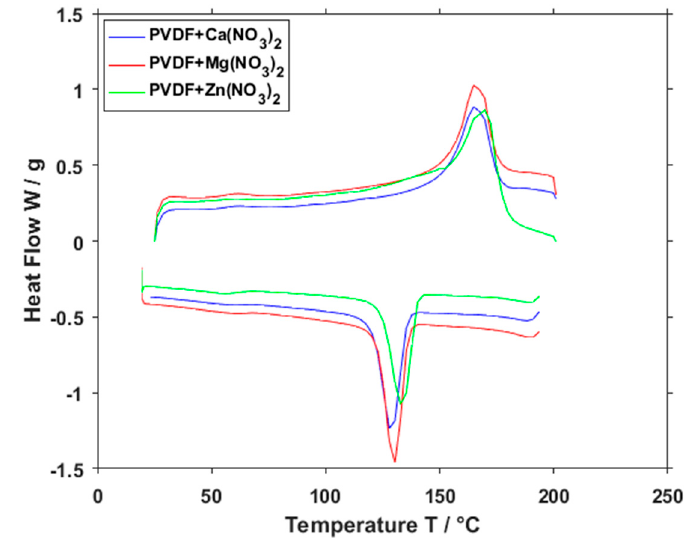
Figure 11. DSC curve of PVDF fibers with Ca(NO 3 ) 2 , Mg(NO 3 ) 2 and Zn(NO 3 ) 2 .